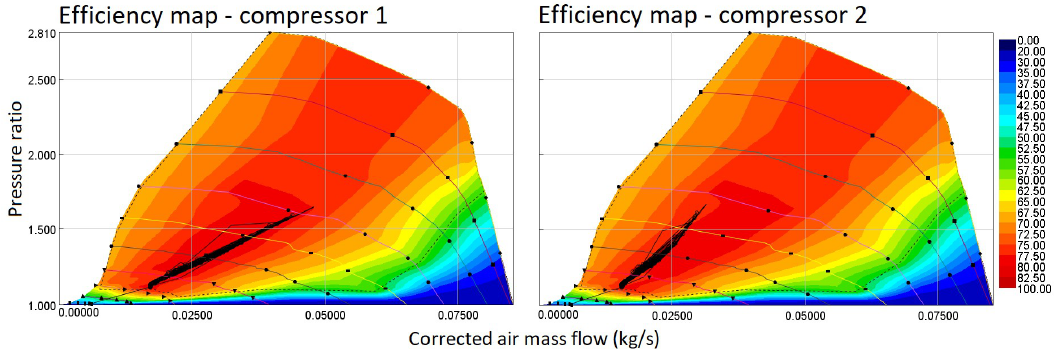
Figure A5. Efficiency map of two-stage centrifugal compressors for PEMFC application.